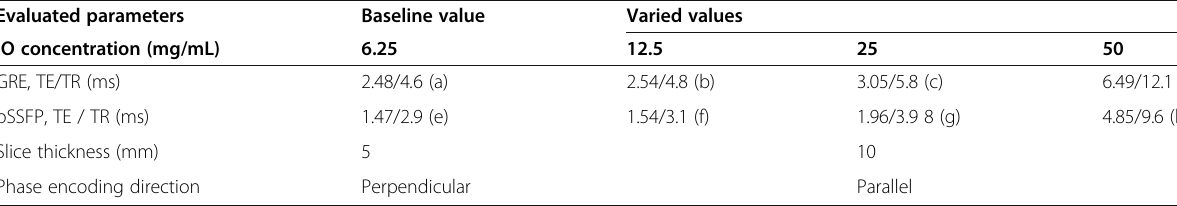
Table 1 Evaluated parameters with corresponding baseline and varied values Evaluated